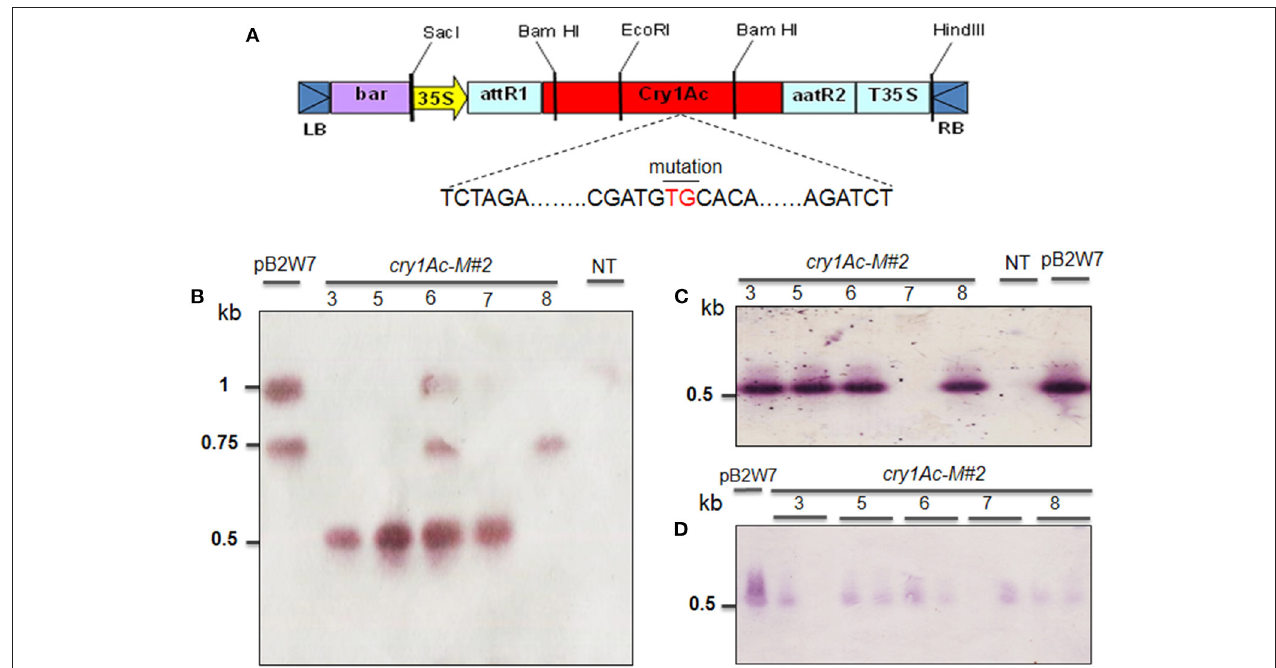
FIGURE 7 | Southern blot analysis of transgenic plant in T1 to T3 generations obtained from Agrobacterium -mediated transformation of VX93 cultivar. The DNA soybean transgenic plant cut by cut by Bam HI and Eco RI enzymes. The process used the probe-bar gene expression in NBT-BCIP. (A) T-DNA structure harbored bar and cry1Ac-M#2 genes (TG nucleotides mutation, red color indicator). (B) T1 generation (left to right), lane 1 is pB2GW7 vector, lane 2 to 6 (five plants), lane 7 is a non-transgenic plant (NT). (C) T2 generation (left to right), lane 1 to 5 (five plants), lane 6 is a non-transgenic plant (NT), and lane 7 is the pB2GW7 vector. (D) T3 generation (left to right), lanes 2–11 (10 plants), and lane 1 is pB2GW7 vector. Plants were chosen randomly for southern blot analysis.